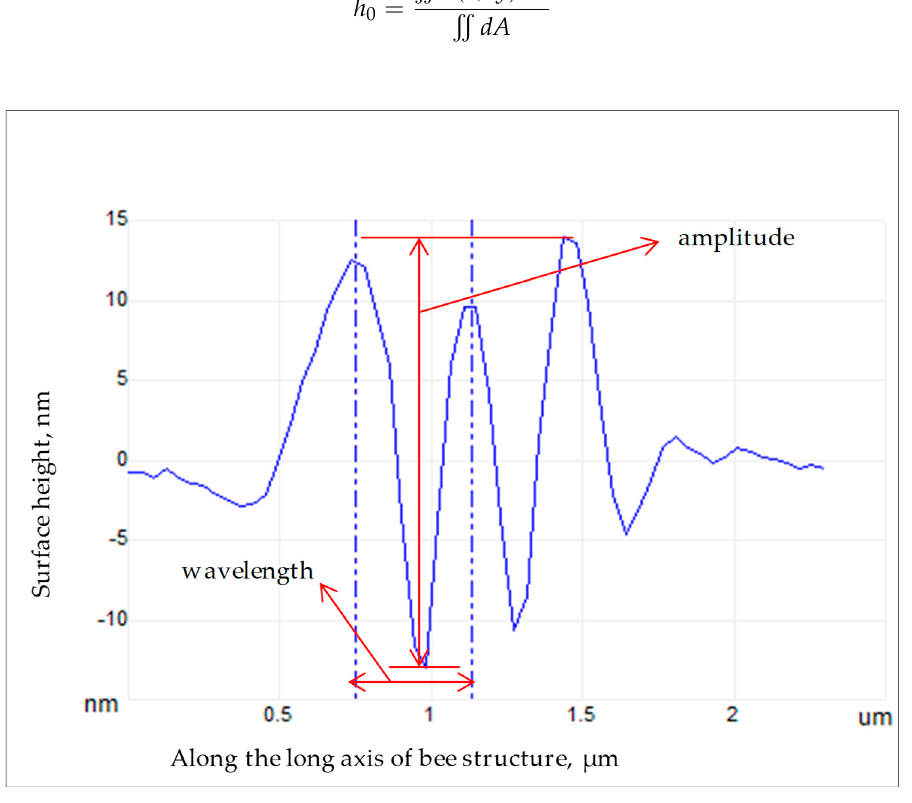
Figure 8. The maximum amplitude.